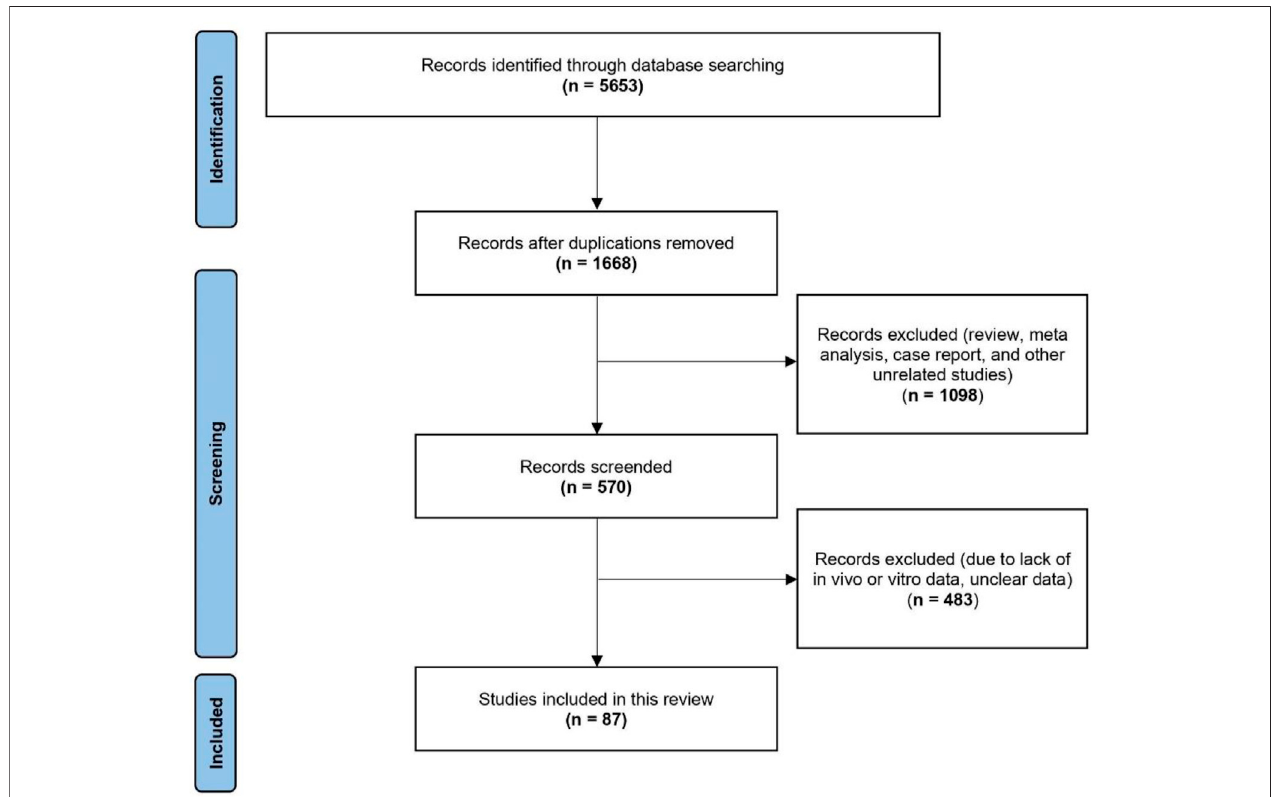
FIGURE 1 | Flow chart of literature search and